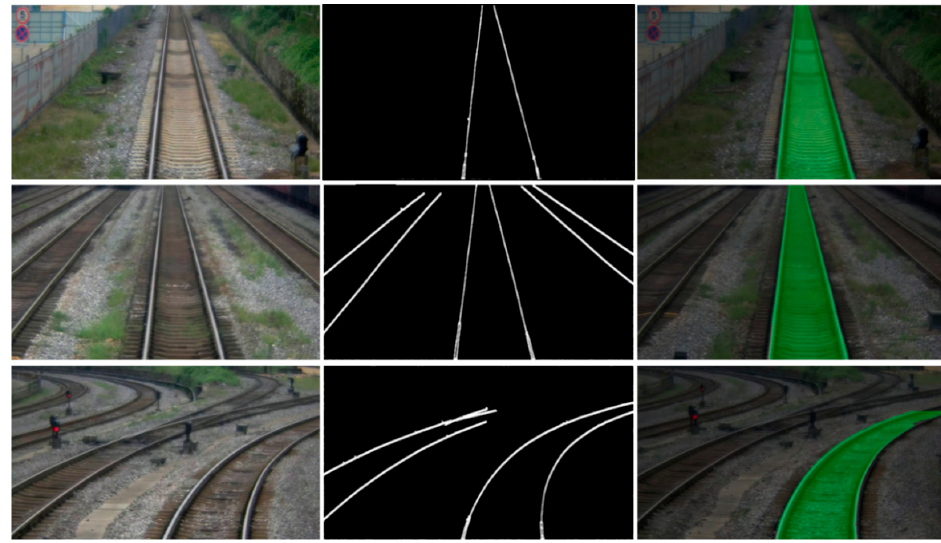
Figure 15. Single set of straight track lines and track region extraction.